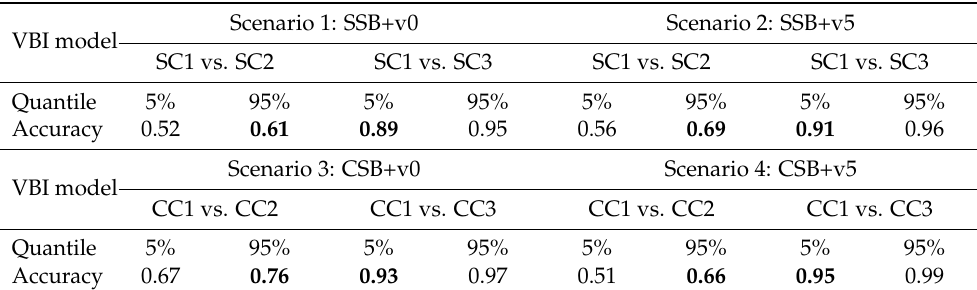
Figure 13. Classification accuracy values using PCA. Table 5. Quantiles of accuracy values using